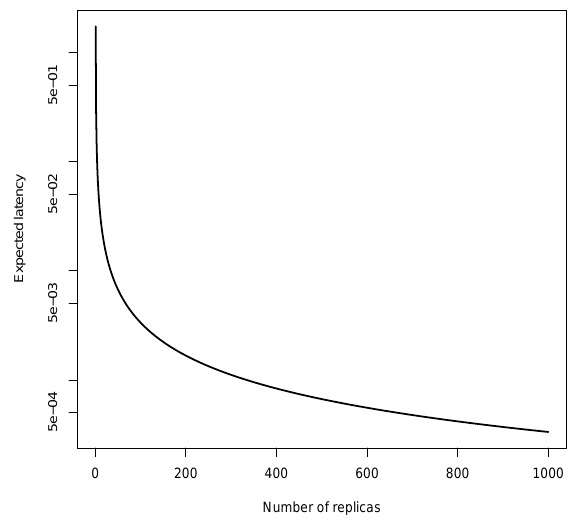
Figure 1: Reduced expected latency in MAP(2)/M/1-type system: the expected latency E ( L ) (log. scale) vs. number of servers (or replicas), c